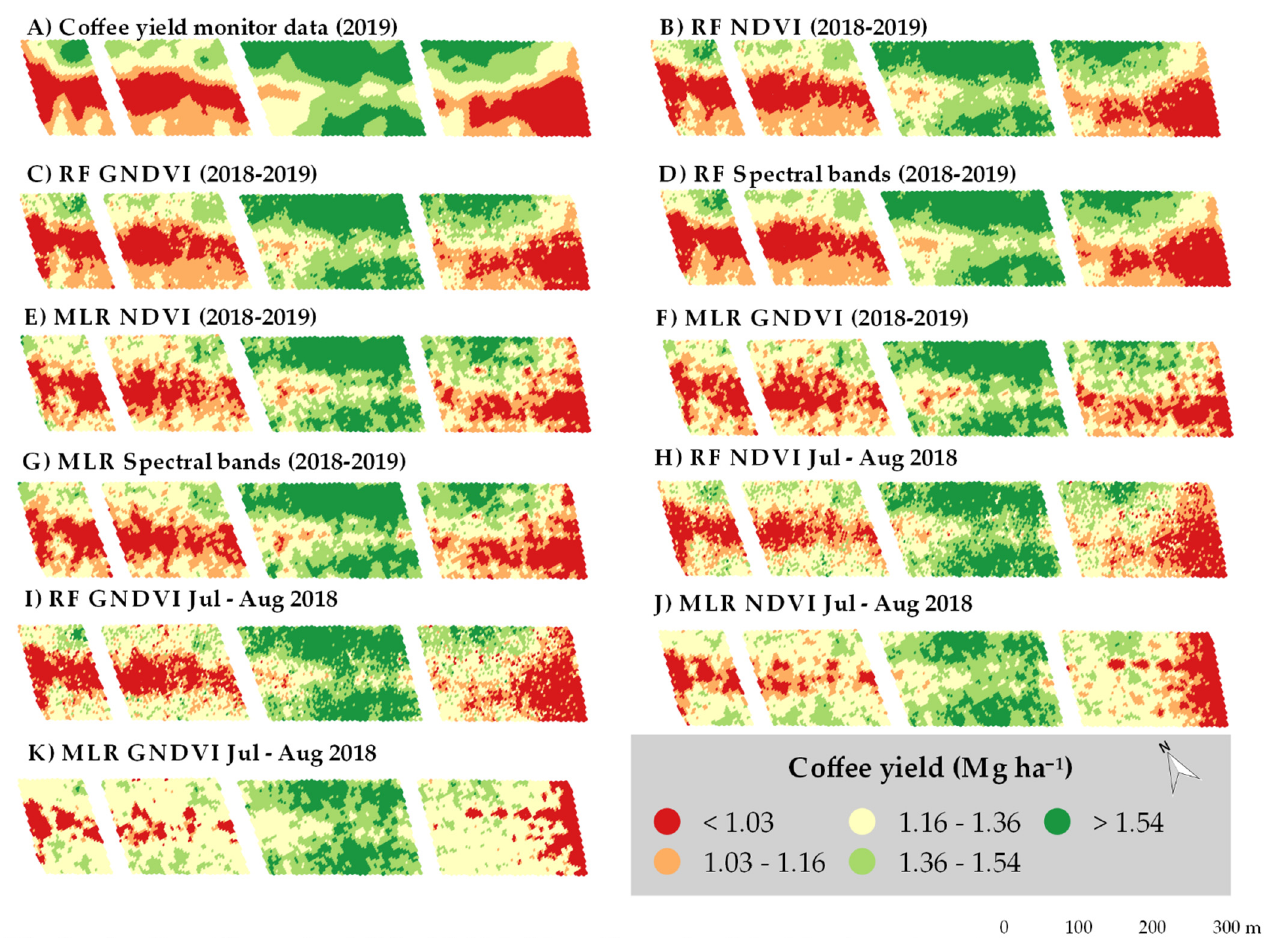
Figure 4. Coffee yield (Mg ha − 1 ) maps generate for harvest 1 (2018–2019) from ( A ) Coffee monitor data/2019; ( B ) RF regression model based on spectral bands/2018/2019, ( C ) RF regression based on NDVI/2018/2019, ( D ) RF regression based on GNDVI/2018/2019, ( E ) MLR based on spectral bands/2018/2019, ( F ) MLR based on NDVI/2018/2019, ( G ) MLR based on GNDVI/2018/2019, ( H ) RF regression based on NDVI obtained in July (jul) and August (ago)/2018, ( I ) RF regression based on GNDVI obtained from July and August/2018, ( J ) MLR based on NDVI obtained from July and August/2018; and ( K ) MLR based on GNDVI obtained from July and August/2018.